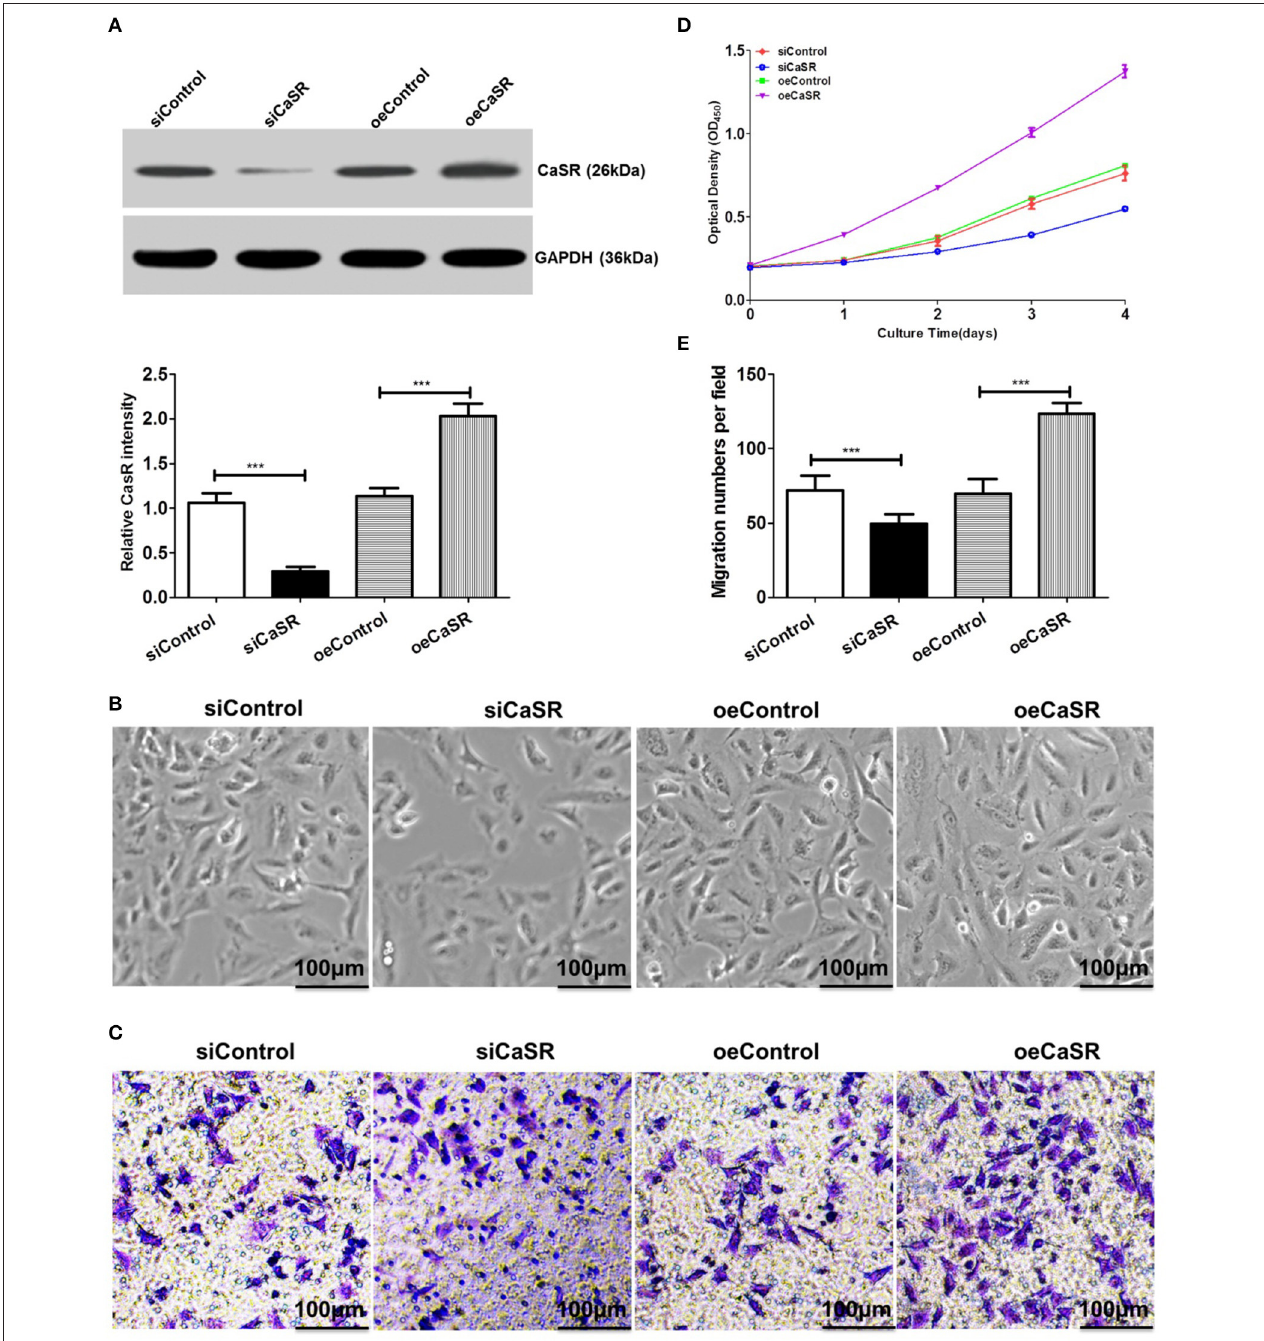
FIGURE 2 | Analysis of proliferation and migration abilities in A549 cells after CaSR knockdown and overexpression. (A) A western blot was used to verify CaSR expression level after cell line construction. CaSR protein expression level in A549 cells was significantly higher in CaSR overexpression group than in control group. CaSR protein expression level in A549 cells after RNA interference was significantly lower than that in negative control group (by about a factor of 0.08; p < 0.001). (B,D) CCK-8 was used to detect A549 cell proliferation. A549 cell proliferation ability was significantly higher in CaSR overexpression group than in control group. A549 cell proliferation ability was significantly lower in CaSR knockdown group than in negative control group ( p < 0.001). (C,E) A549 cell invasion ability was examined by transwell assay. Number of transmembrane cells was significantly greater in CaSR overexpression group than in control group and the difference was statistically significant ( p < 0.001). Number of transmembrane cells was significantly lower in CaSR knockdown group than in negative control group and the difference was statistically significant ( p < 0.001). *** p < 0.001.